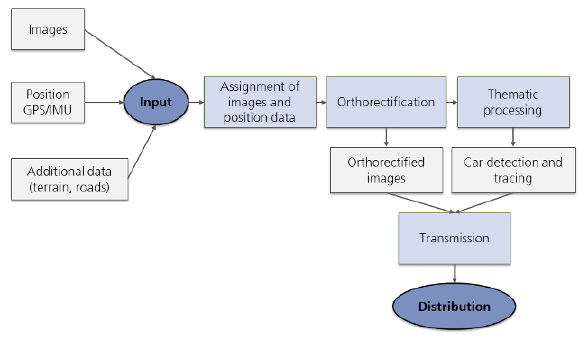
Figure 4: Workflow of the 4k camera system